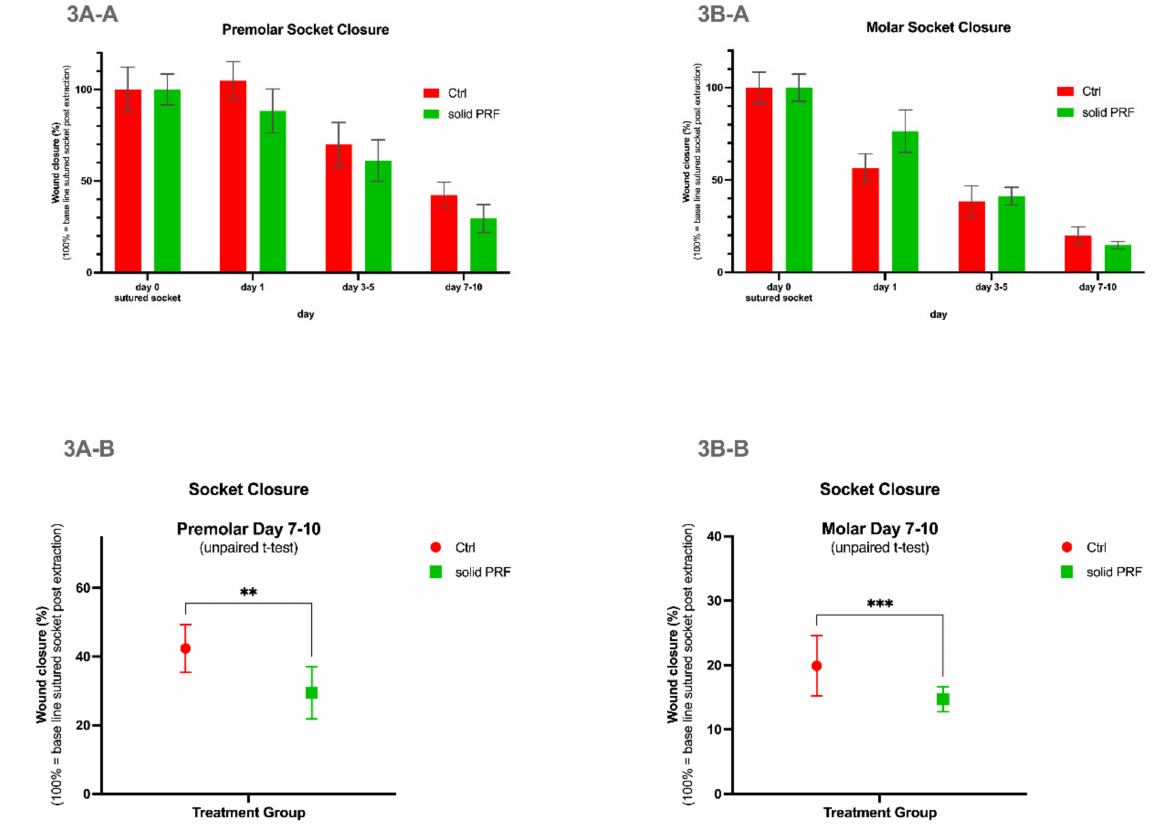
Figure 3. Wound healing—quantitative socket closure evaluation. Soft tissue wound closure was evaluated in premolars ( 3A ), and molars ( 3B ) up to day 7–10 post tooth extraction. Wound closure was continuously progressing over time in both control and solid PRF-treatment groups for premolars ( 3A-A ) and molars ( 3B-A ). At the final evaluation time point (7–10 days post extraction), the remaining wound size was statistically significantly larger in the control patient group as compared to patients in solid PRF treatment group in both premolars ( 3A-B ) and in molars ( 3B-B ). Data are represented as mean ± SEM for wound healing progression ( 3A-A , 3B-A ), and mean ± SD for residual wound size at days 7–10. Significance levels are as follows: “**” p < 0.01; “***” p <